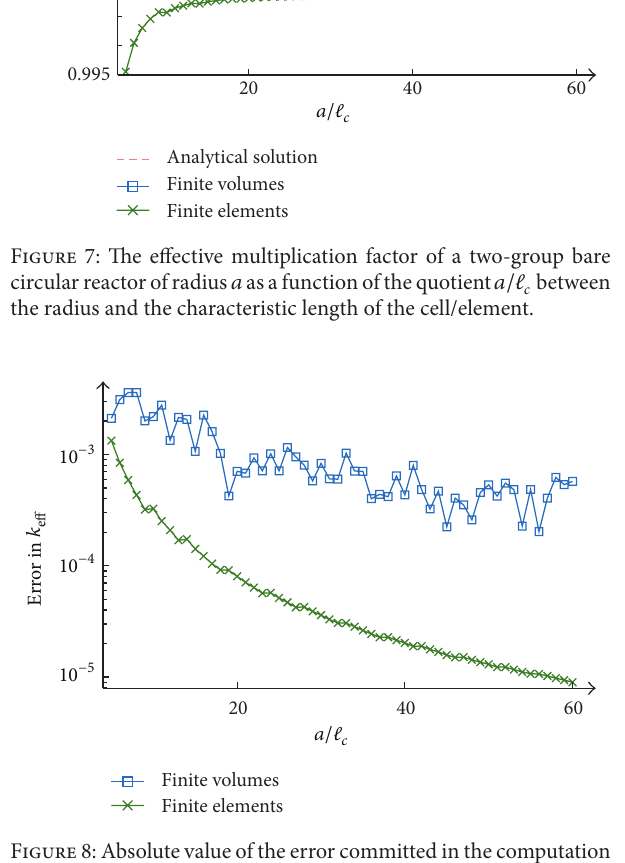
Figure 8: Absolute value of the error committed in the computation versus 𝑎/ℓ 𝑐 . of 𝑘 eff